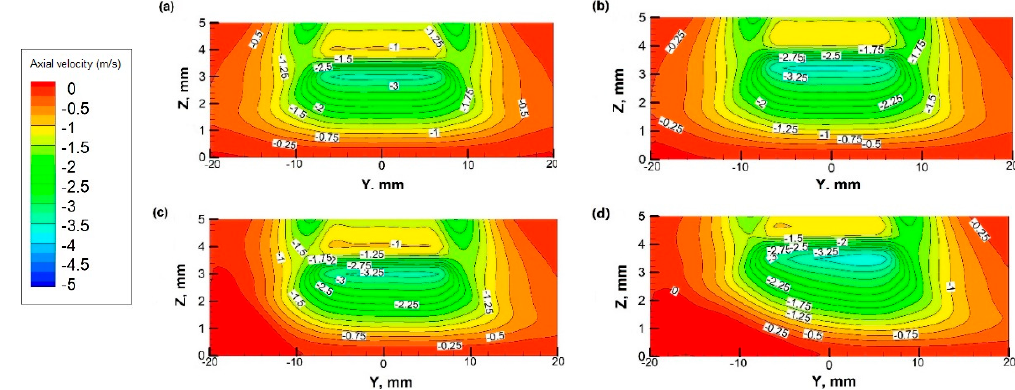
Figure 6. Axial velocity contours at di ff erent rotational speed in Y - Z plane (unit: m / s): ( a ) ω = 0; Figure 6. Axial velocity contours at different rotational speed in Y-Z plane (unit: m/s): ( a ) ω = 0; ( b) ω Figure 6. Axial velocity contours at different rotational speed in Y-Z plane (unit: m/s): ( a ) ω = 0; ( b) ω ( b ) ω = 100 rpm; ( c ) ω = 300 rpm; ( d ) ω = 600 rpm. = 100 rpm; ( c) ω = 300 rpm; ( d) ω = 600 rpm. = 100 rpm; ( c) ω = 300 rpm; ( d) ω = 600 rpm. Figure 6. Axial velocity contours at different rotational speed in Y-Z plane (unit: m/s): ( a ) ω = 0; ( b) ω = 100 rpm; ( c) ω = 300 rpm; ( d) ω = 600 rpm.